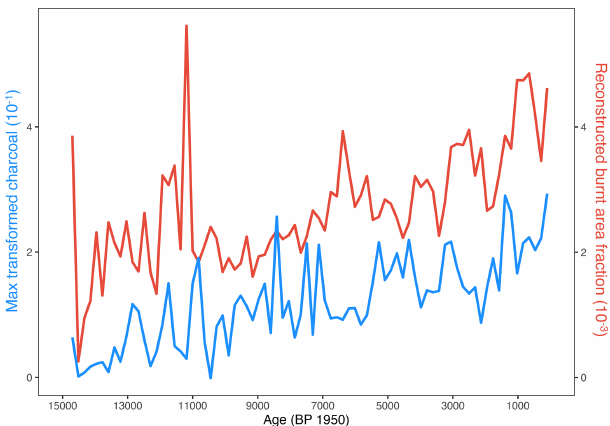
Figure 5. Composite plots comparing maximum-transformed char- coal values and the reconstructed burnt area for these entities for the 51 entities with charcoal. Maximum-transformed charcoal is shown in blue; burnt area fraction is shown in red. The loess smoothing is done with a span of 0.04.